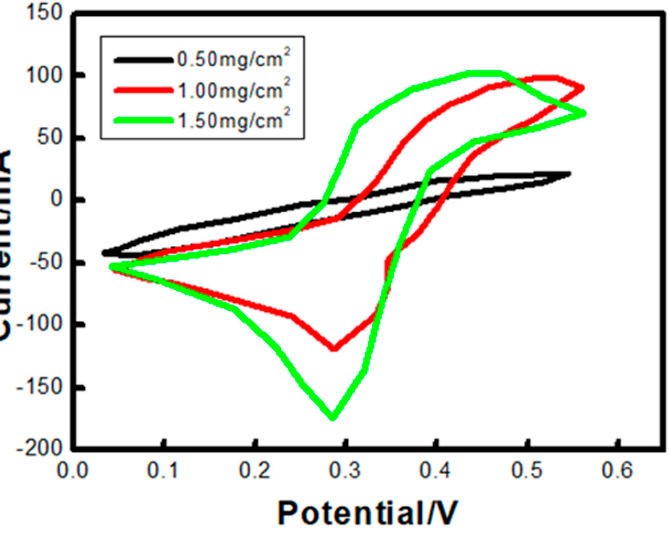
Figure 9. Cyclic voltammograms of [BiFe 1 − x Li x O 3 ]-graphene composites loaded electrodes in air saturated 1 M KCl solution.